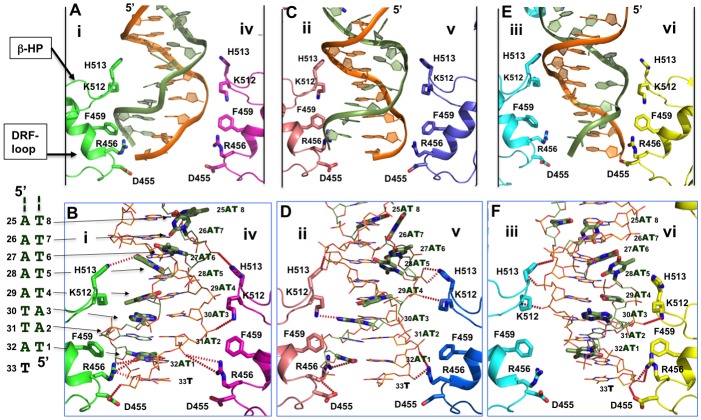
Detailed interactions of origin DNA with the AAA+ domain.(A, C, E) Detailed interactions of DNA with three pairs of subunits within the LT hexamer: subunit pair i & iv (A), ii & v (C), and iii & vi (E). The β-hairpin residues K512/H513 and DRF loop residues D455/R456/F459 that bind to the DNA are labeled. (B, D, F) The detailed interactions of the oriDNA with the same three pairs of LT subunits shown in (A) [matching B], (C) [matching D], and (E) [matching F]. Dashed lines indicate hydrogen-bond interactions between LT residues and DNA (in the stick model). Some of LT residues are 5–7 Å away from DNA, and would be suitable for the water-mediated formation of hydrogen bonding. In addition, a number of LT residues are within Van der Waals distance of the bound DNA, forming hydrophobic packing interactions; these residues include K512 of subunit i (i-K512), i-F459, iv-F459, ii-F459, v-F459, vi-F459, and vi-H513. The dislocated bases in the disrupted bases-pairs (in the partially melted DNA region) are drawn in thick sticks, with the DNA sequences of this region shown to the left of panel B. The structure shows clearly that identical residues on different subunits make unique contacts with the phosphate backbones and the major or minor gr oves of the DNA; this is possible due to the near-planar arrangement of the six subunits.